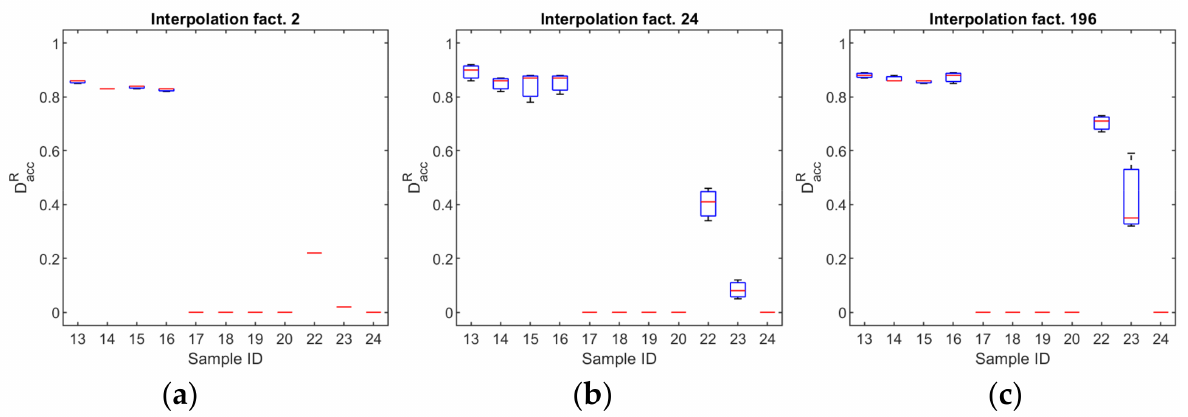
Figure 23. Absolute overall detection accuracy for the correct joint for different interpolation factors: ( a ) 2, ( b ) 24, ( c ) 192.